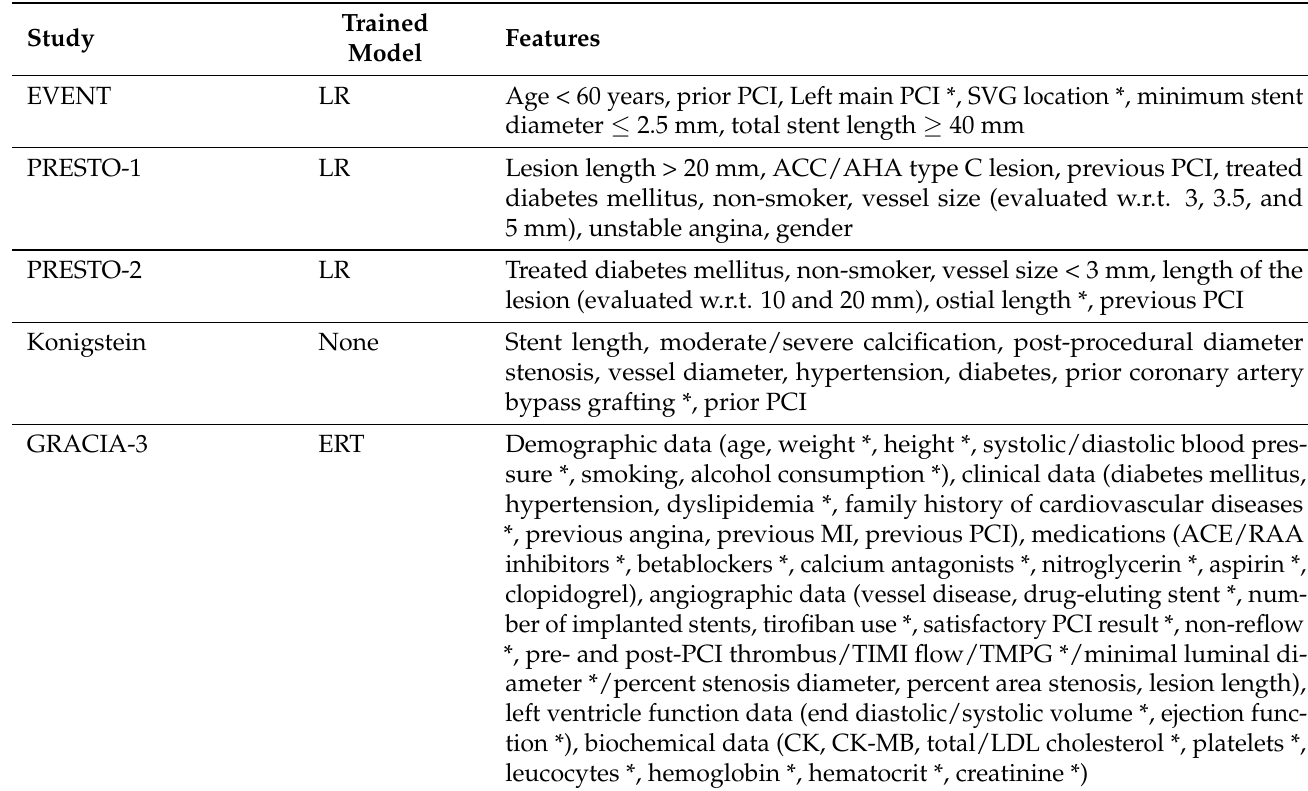
Table 3. Features and models used in the original literature for each of the five state of the art models. * = the feature is missing in our dataset and was excluded in the retrained